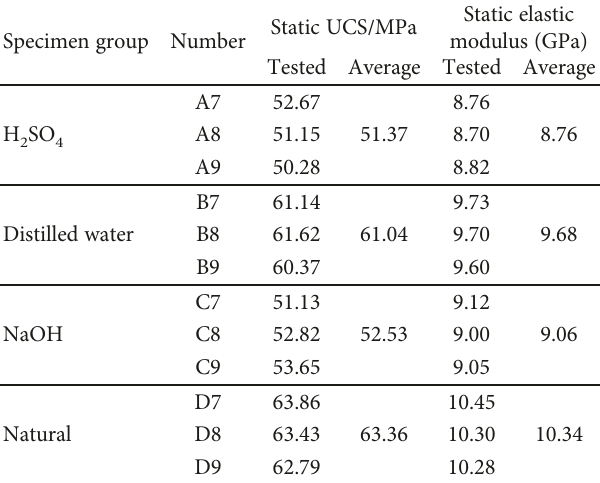
Figure 6: Static stress – strain curves of the sandstone specimens subjected to di ff erent chemical solutions. Table 3: Static uniaxial compression test results for specimens with di ff erent chemical